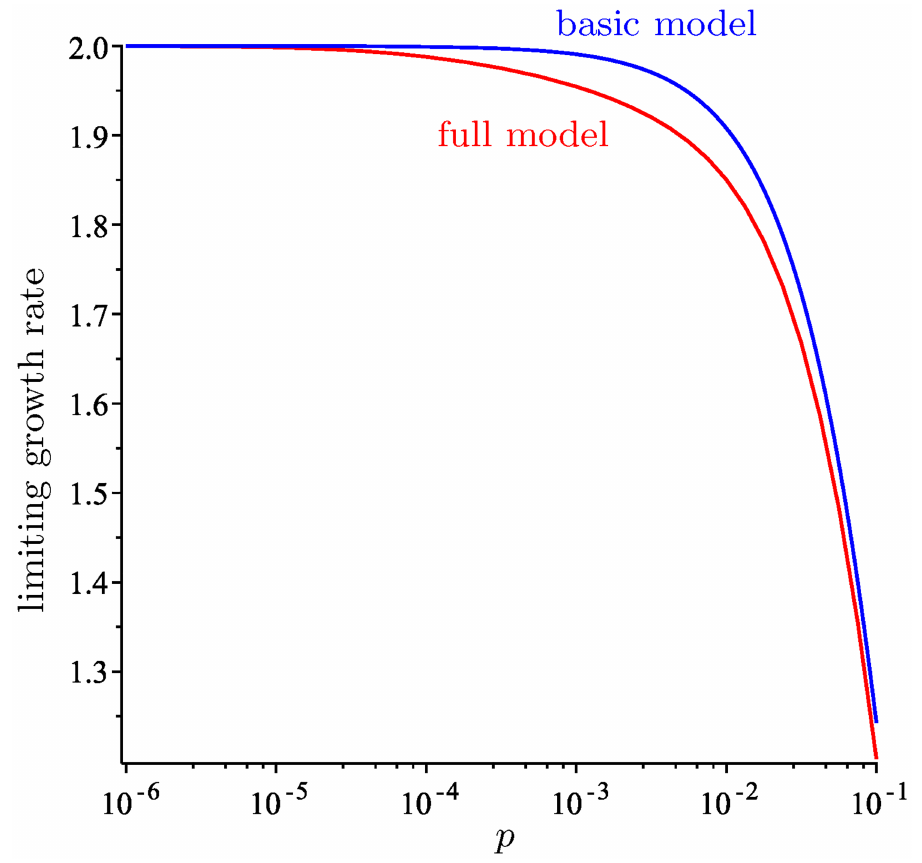
Fig 5. The limiting growth rate for the full model with N = 8 and the standard parameters. The limiting growth rate is graphed in red as a function of p . Fig 2A has been overlaid in blue for